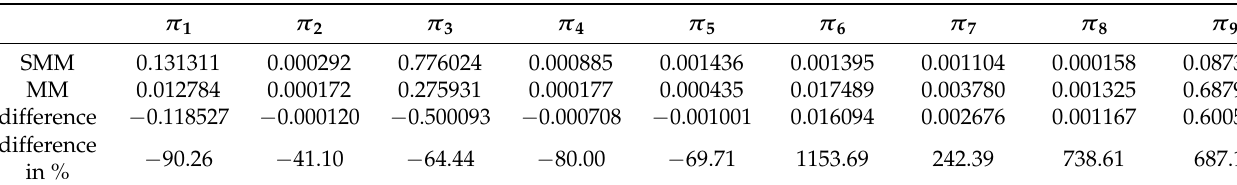
Table 10. Comparison of results obtained by MM and SMM.